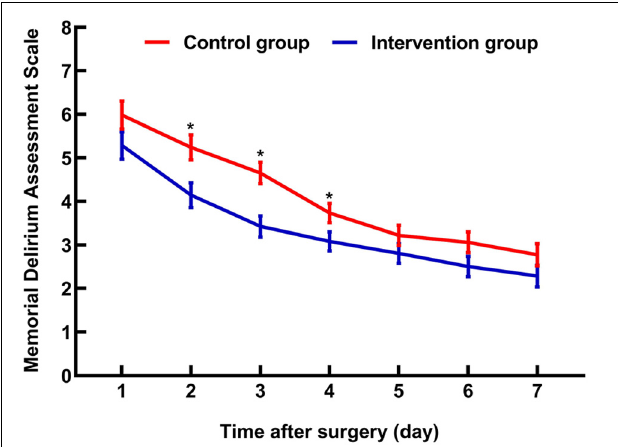
FIGURE 4 | Changes in Memorial Delirium Assessment Scale during the first postoperative seven days. Makers indicate means, and error bars indicate standard errors. *Significant difference between groups.